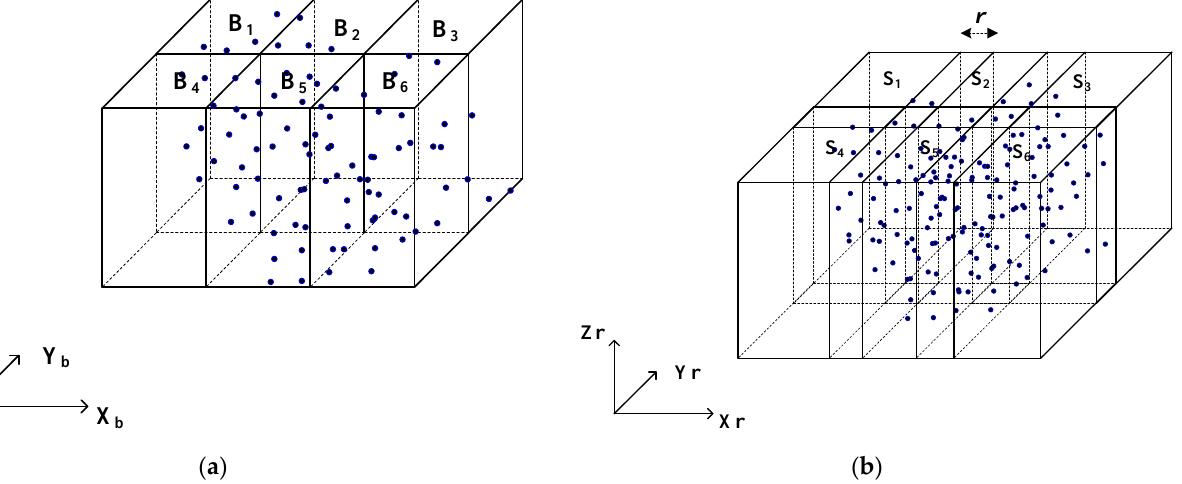
Figure 5. The AABB bounding box of the search range. ( a ) The bounding box of the base model space feature points. ( b ) The searching bounding box of the model space feature points to be regis- tered.